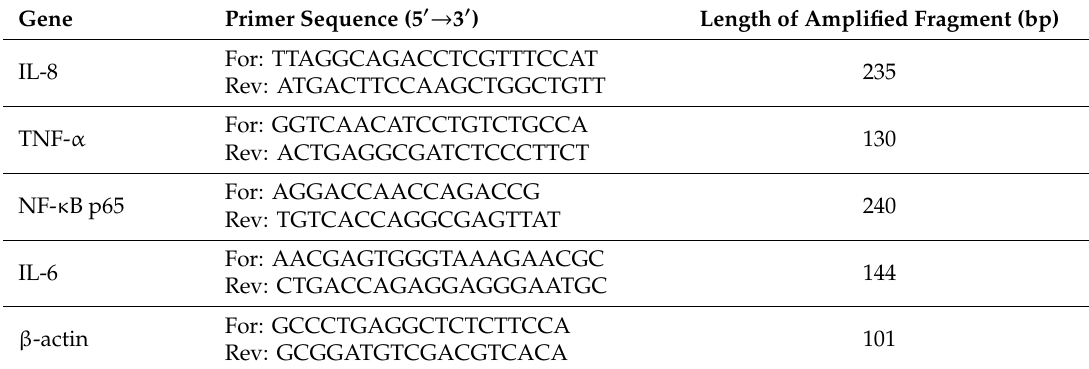
Table 1. Primers for